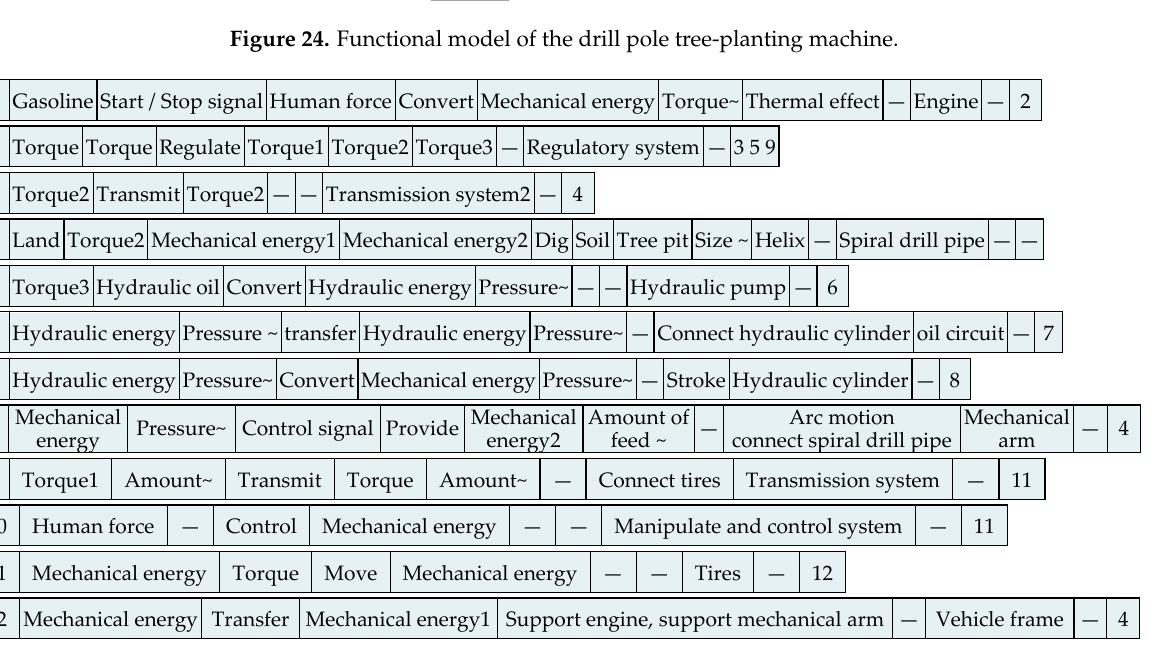
Figure 25. Product genome of the drill pole tree-planting machine.